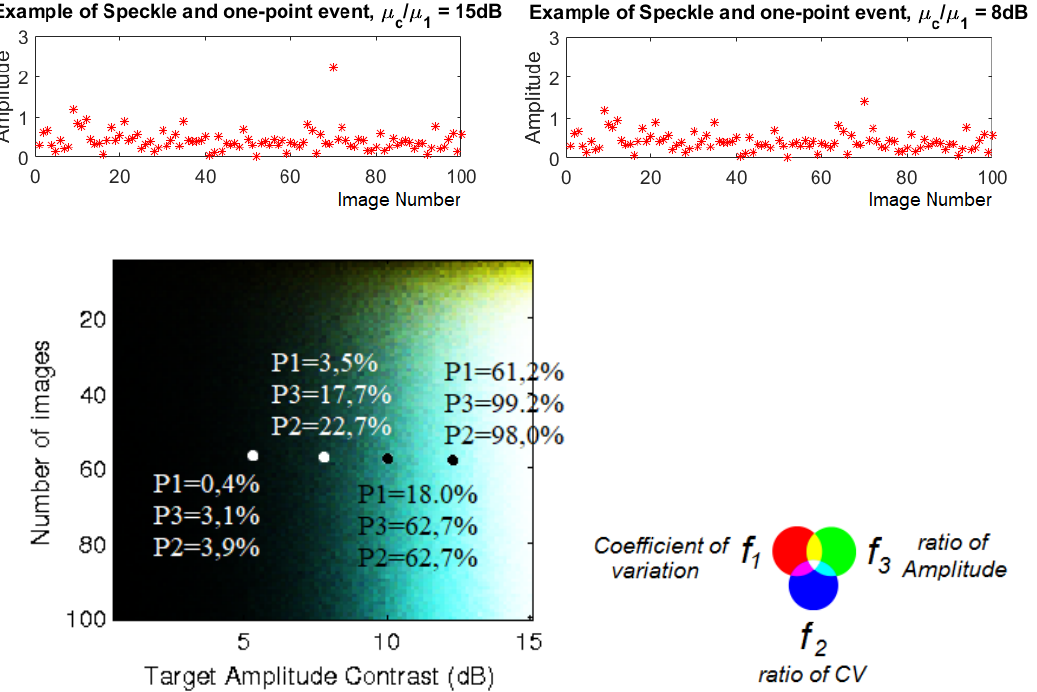
Figure 3. Top: examples of simulated profiles with Rayleigh and one-point event, for two contrast ratios. Bottom: probability of detection of f 1 , f 2 , f 3 , for False Alarm 0.1%, for profiles containing a target at a single time, for a varying number of images and varying